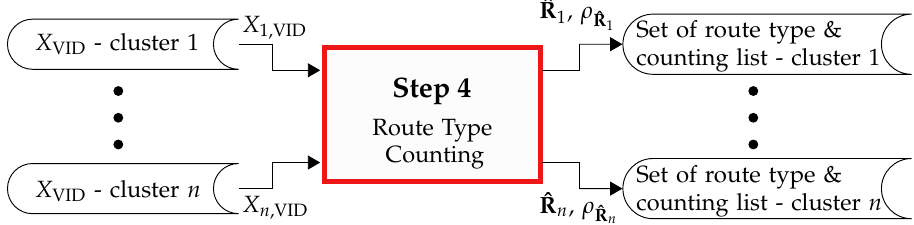
Figure 10. Overview of step 4 of the PROMOTING method: the route-type counting.